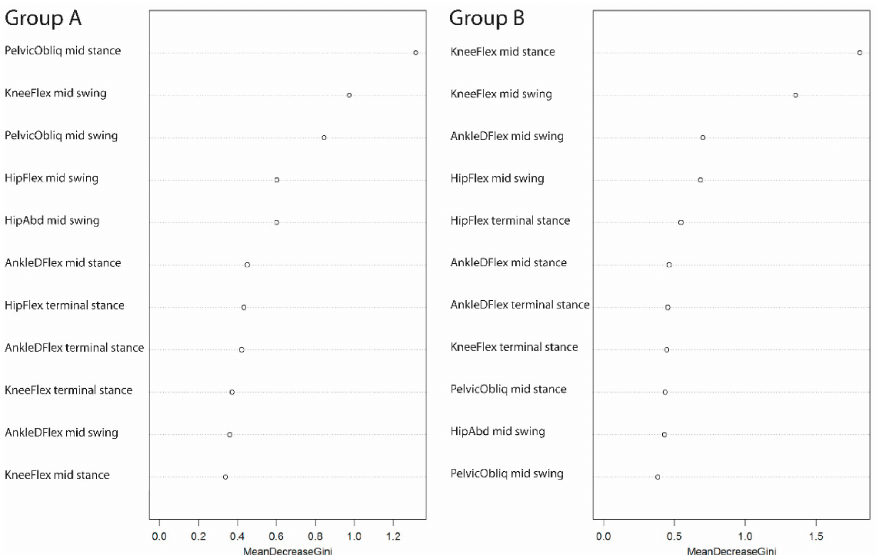
Figure 4. Utilizing the two group classification random forest models. The variable list extracted by the Gini importance index when classifying individuals exhibiting a longer left or right anatomic lower limb (on the left—group A, on the right—group B). A high value indicates the great importance of a variable for accurate classification.